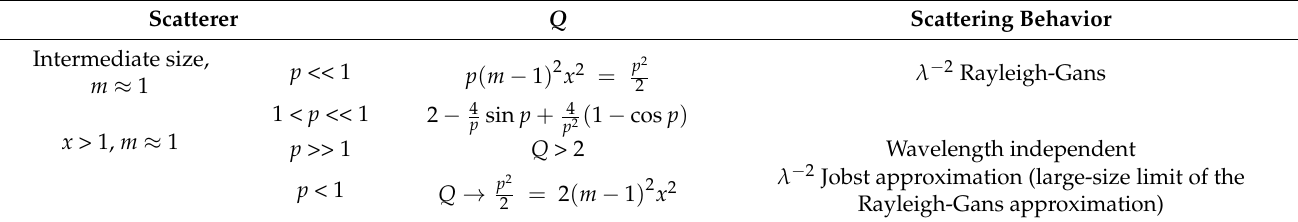
Table 2. Scattering efficiency factors Q